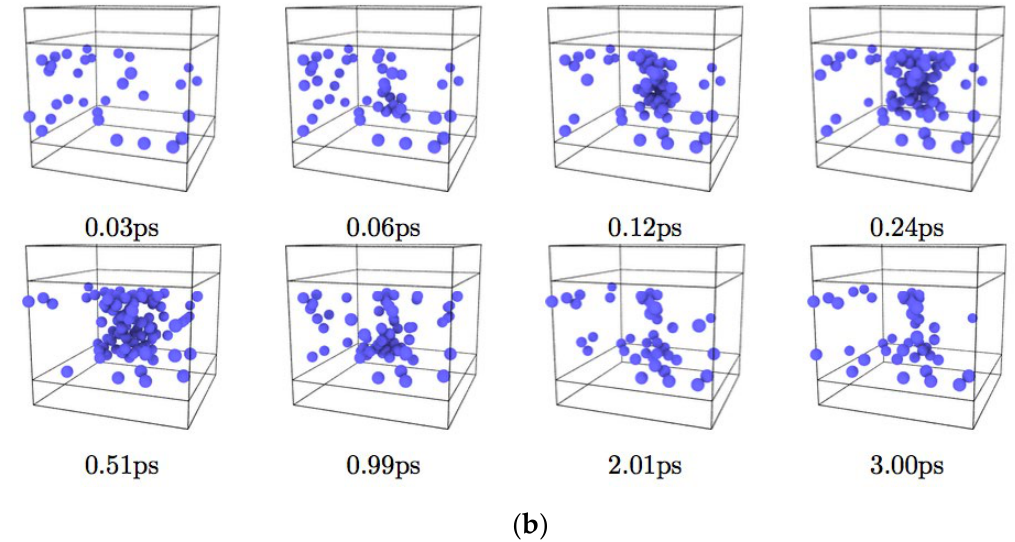
Figure 6. Distributions of vacancies in the CeO 2 systems viewed from ( a ) <001> and ( b ) <100> directions for the values of gSe = 0.2 keV/nm.